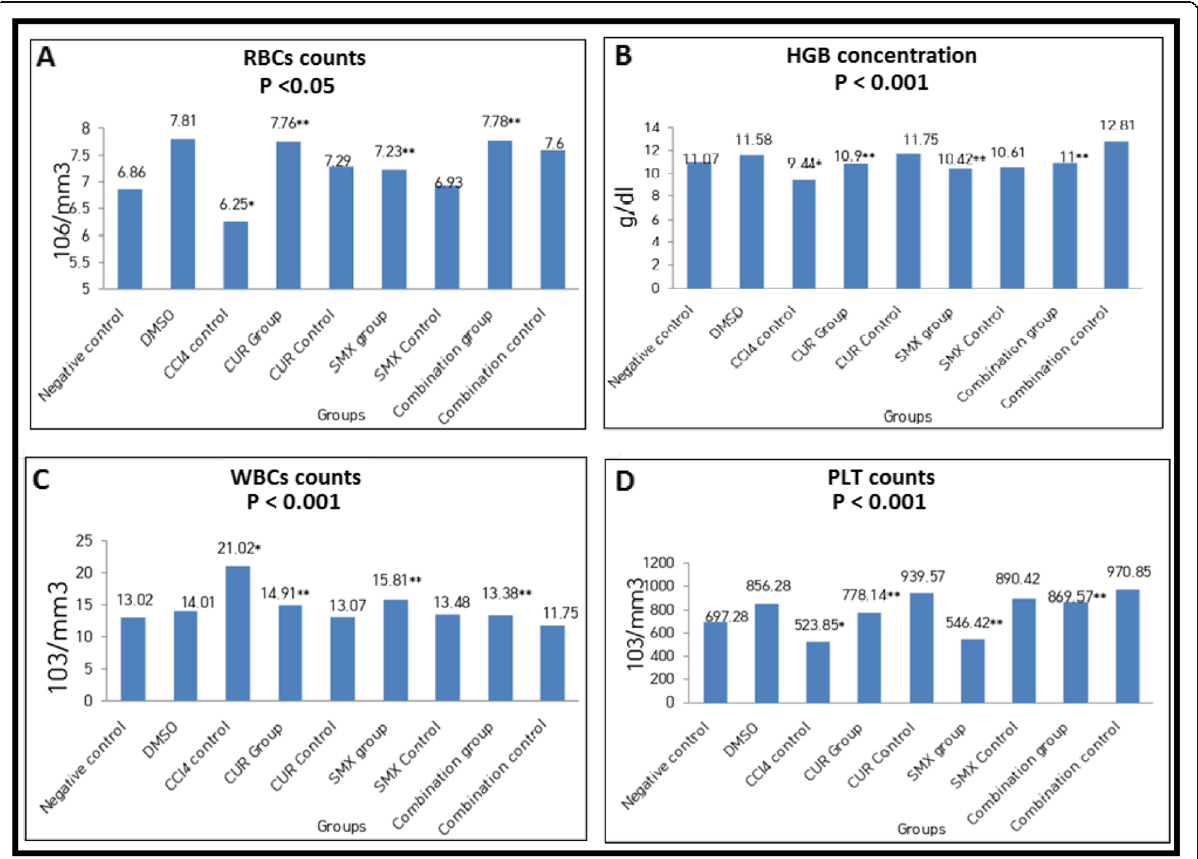
Fig. 8 Effect of curcumin and sulfamethoxazole on hematological changes in all studied groups. a RBCS counts, b HGB concentrations, c WBCs counts. d PLT counts. Results were expressed as mean (*) compared with normal control, (**) compared with CCl 4 control, and showed a highly significant difference from control value at ( p < 0.001) except for RBCs which was at ( p <